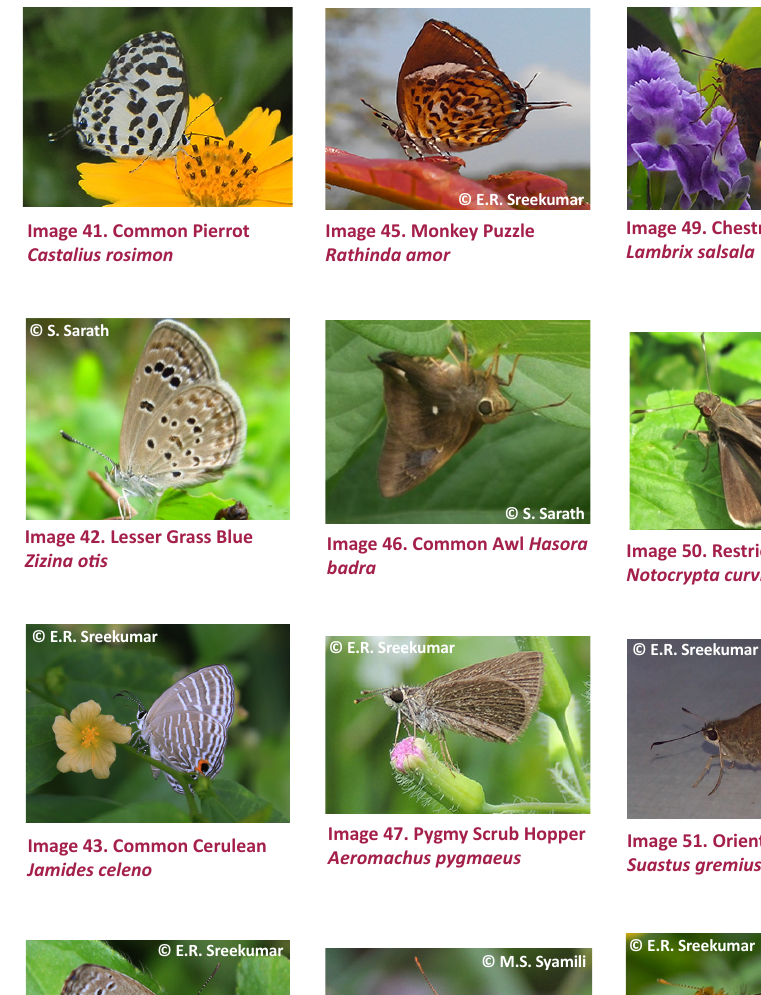
Image 52. Dark Palm Dart Telicota colon